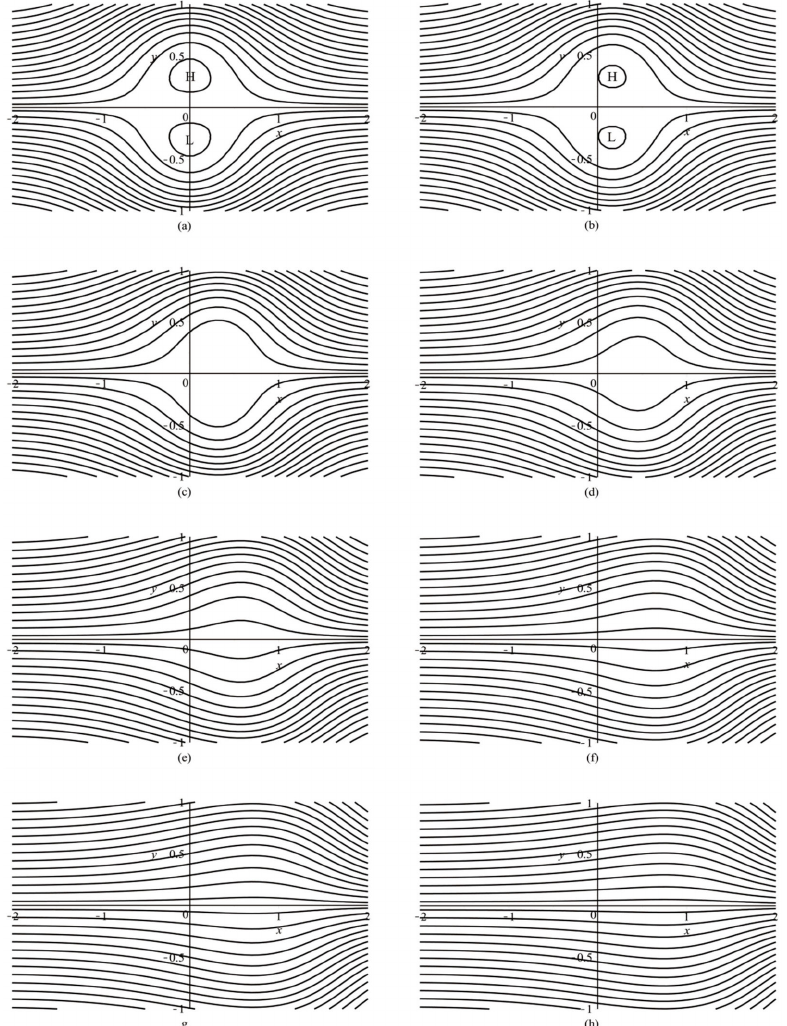
Figure 4. Blocked flow field for a dipole when ∆ T = − 12 ◦ C on the ( a ) 1st, ( b ) 5th, ( c ) 9th, ( d ) 13th, ( e ) 17th, ( f ) 21st, ( g ) 25th, and ( h ) 29th day (unit: 1500